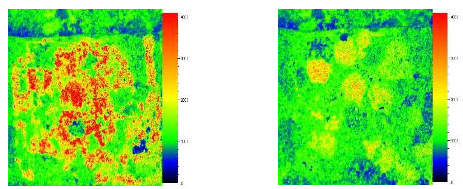
Figure 4. Maps of the maximum quantum yield of PSII calculated by (F m -F 0 )/F m , before (left) and after (right) the treatment.